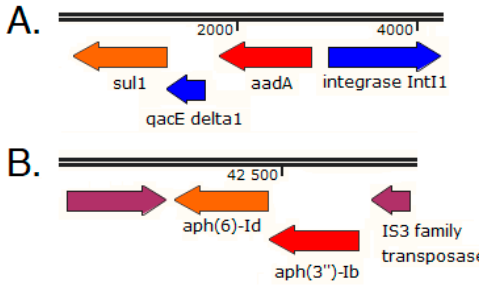
Figure 6. ( A ) Schematic structure of an A. hydrophila class 1 integron, as determined by PCR mapping experiments. IntI1: class 1 integrase, aadA : aminoglycoside-adenyltransferase, qacE ∆ 1 and sul1 : the 3 (cid:48) -Conserved Sequence (3 (cid:48) -CS) [77]. ( B ) Immediate genetic environment of the aph(6)-Id and aph(3”)-Ib genes carried by the Moellerella wisconsensis strain W1 plasmid pW1-a (NCBI Accession CP093256).